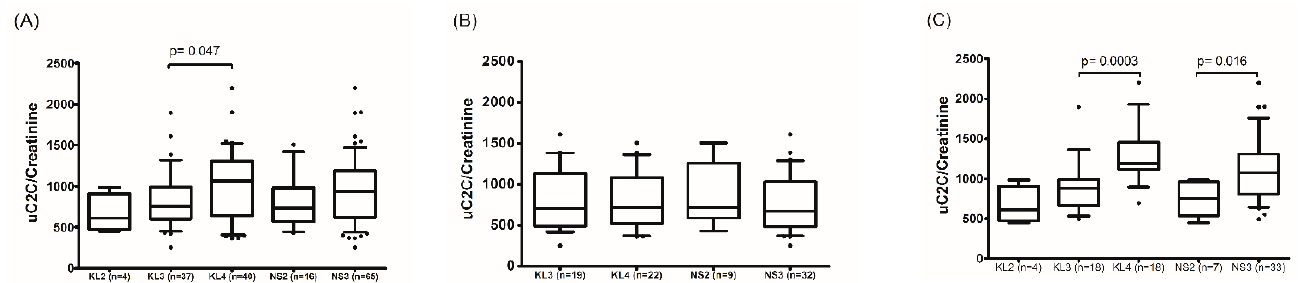
Figure 2. The association of uC2C levels with the radiological severity of kOA in the preoperative period in ( A ) the whole group, ( B ) males, and ( C ) females (boxplot with 10th–90th percentiles, Wilcoxon paired test). KL—grades of radiographic knee osteoarthritis by the Kellgren–Lawrence scoring system; NS—the highest grade of knee OA changes in two knee joint compartments (tibiofemoral and/or patella–femoral joints) by the Nottingham system (NSy).